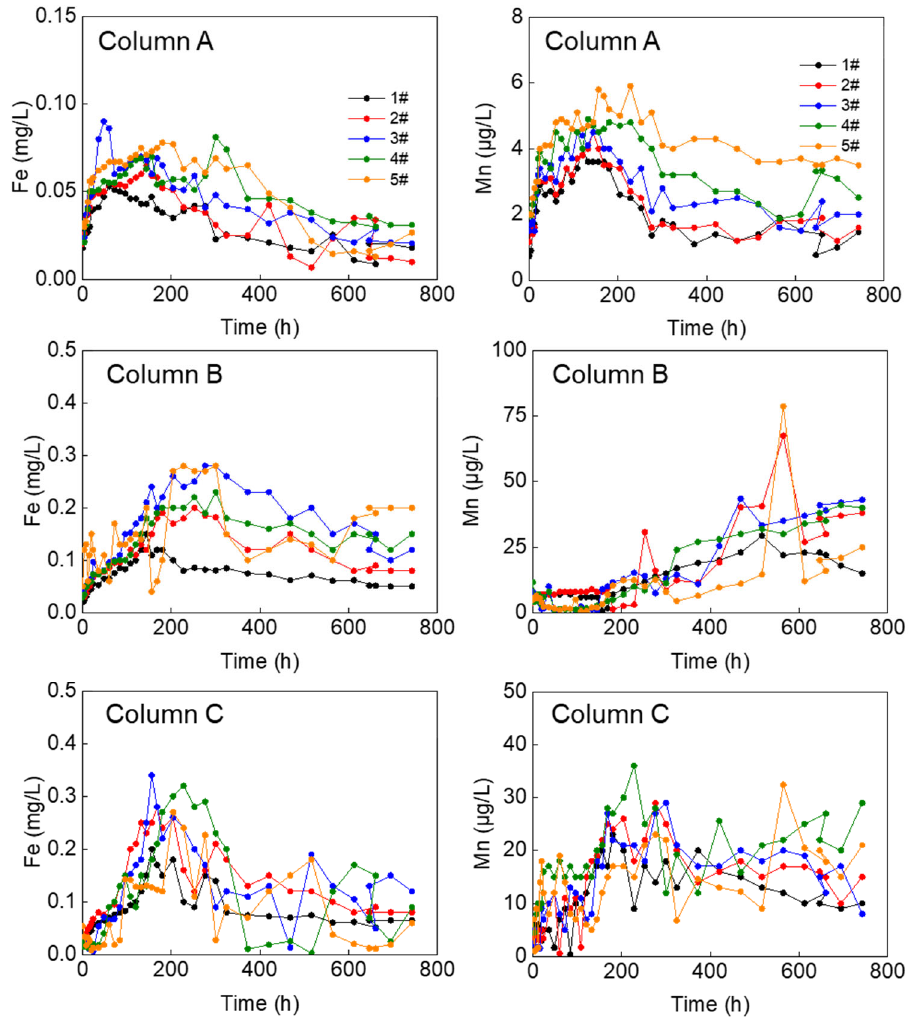
Figure 3. Changes of Fe and Mn concentrations.